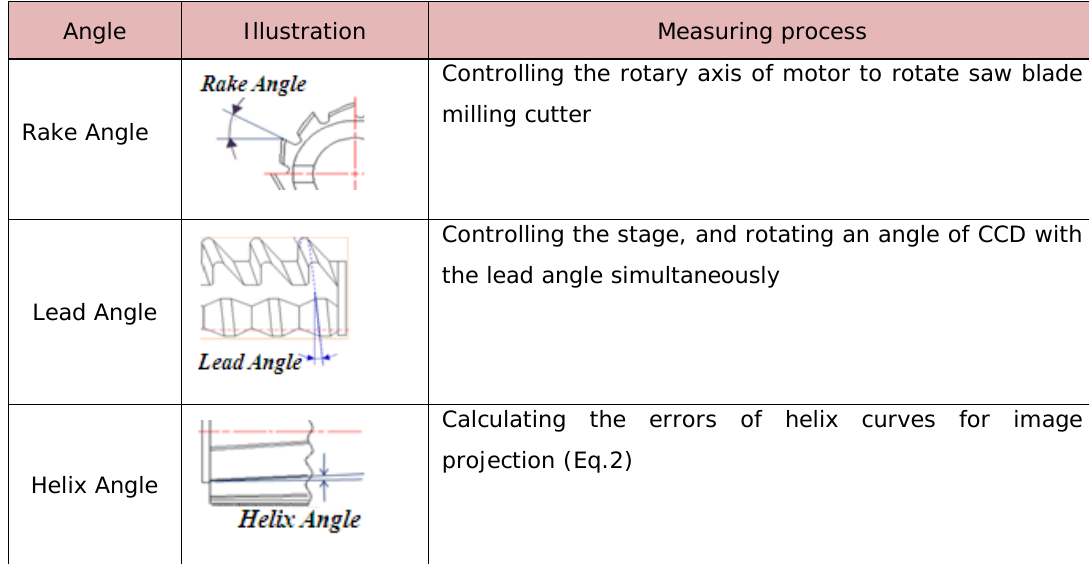
Table 1. “Measured angles”.